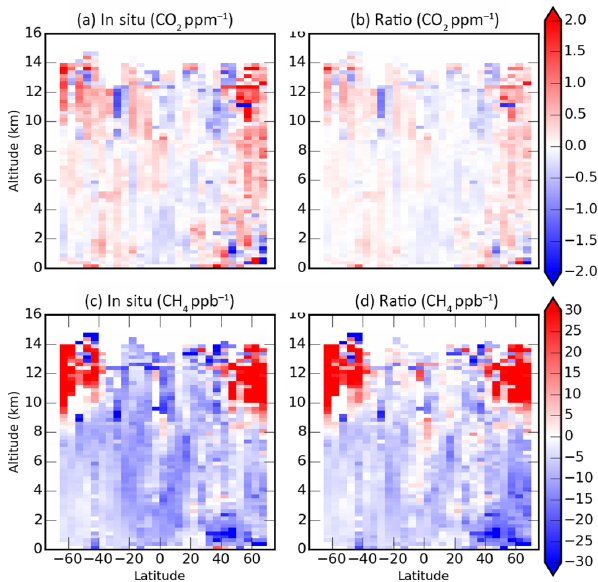
Figure A1. Differences between observed and (a, c) in situ and (b, d) ratio a posteriori model (a, b) CO 2 and (c, d) CH 4 mole fractions observed during HIPPO experiments 1–5 (Wofsy et al., 2011) that cover individual periods during 2009, 2010, and 2011. Model and observation are gridded on a latitude interval of 5 ◦ and a vertical interval of 500m.